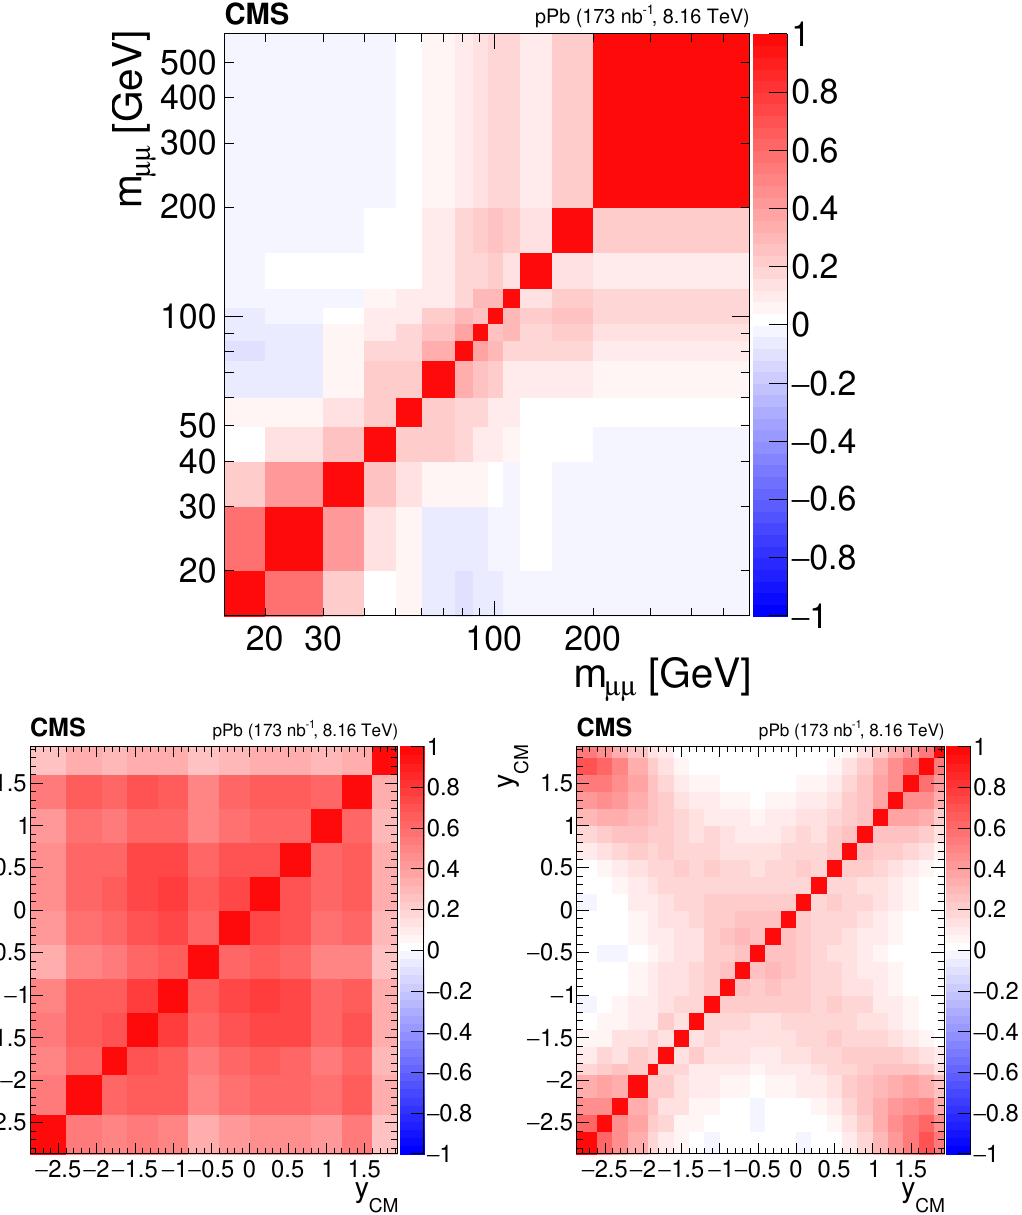
Figure 3 . Correlation matrix for the systematic uncertainties, excluding integrated luminosity, as a function of the dimuon invariant mass (upper) and rapidity in the centre-of-mass frame for 15 < m < 60 GeV (lower left) and 60 < m < 120 GeV (lower mm mm